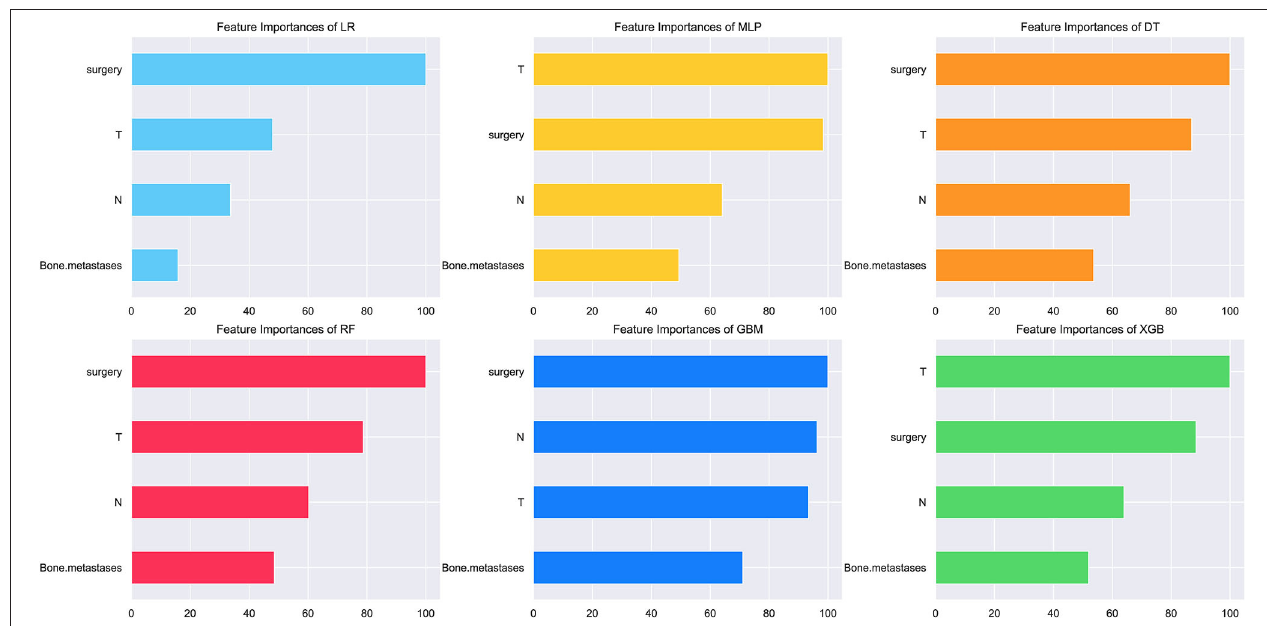
FIGURE 3 | The relative importance of variables for the prediction of LM using ML algorithms. Surgery, T-stage and N-stage ranked in the top three in all prediction models, with bone metastasis ranked